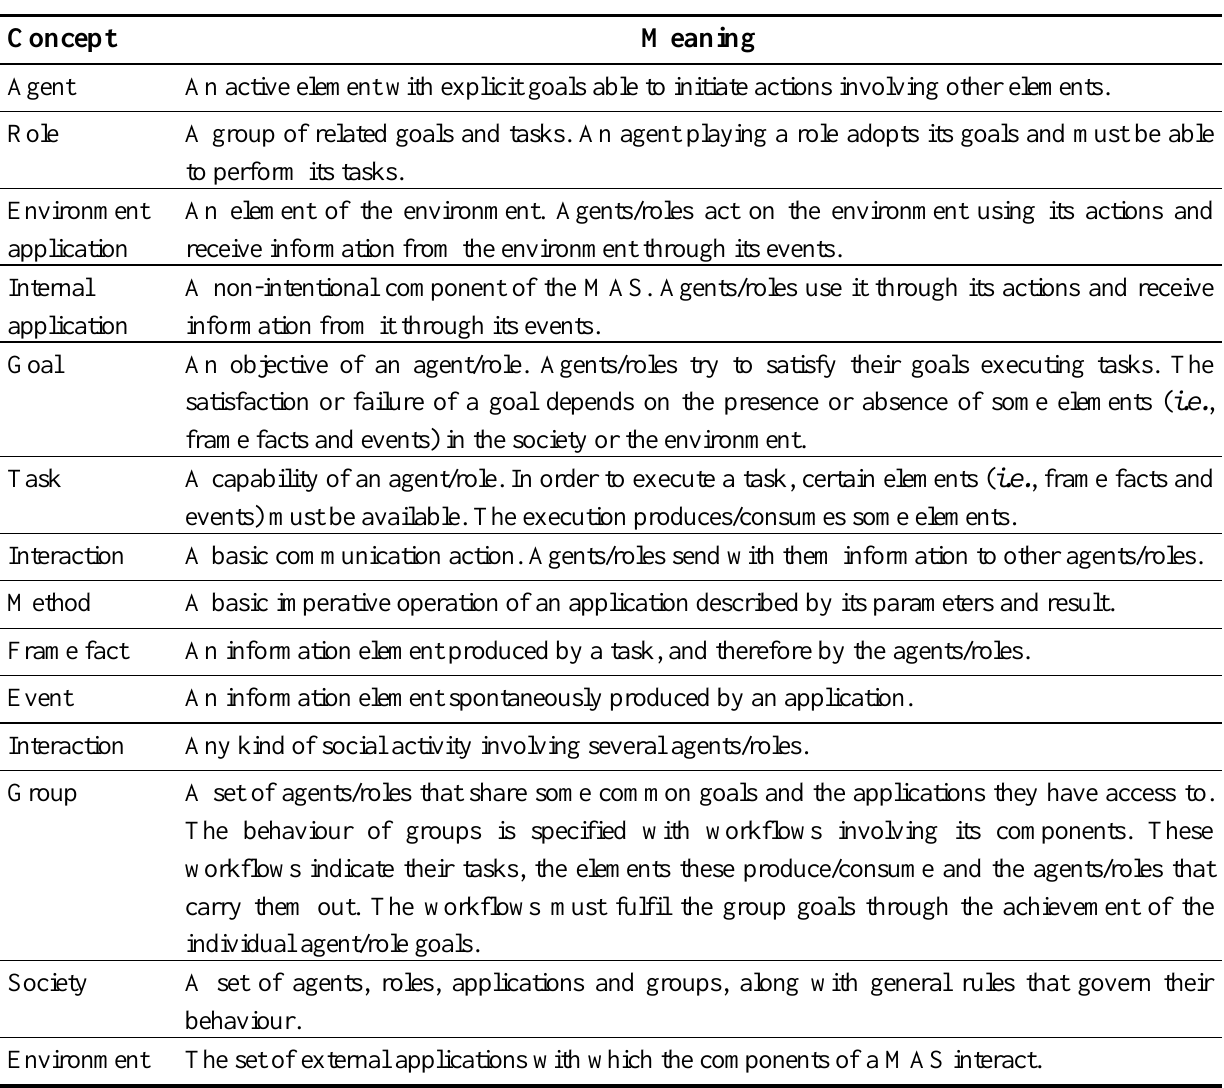
Table 1. Main concepts of the modelling language of the INGENIAS